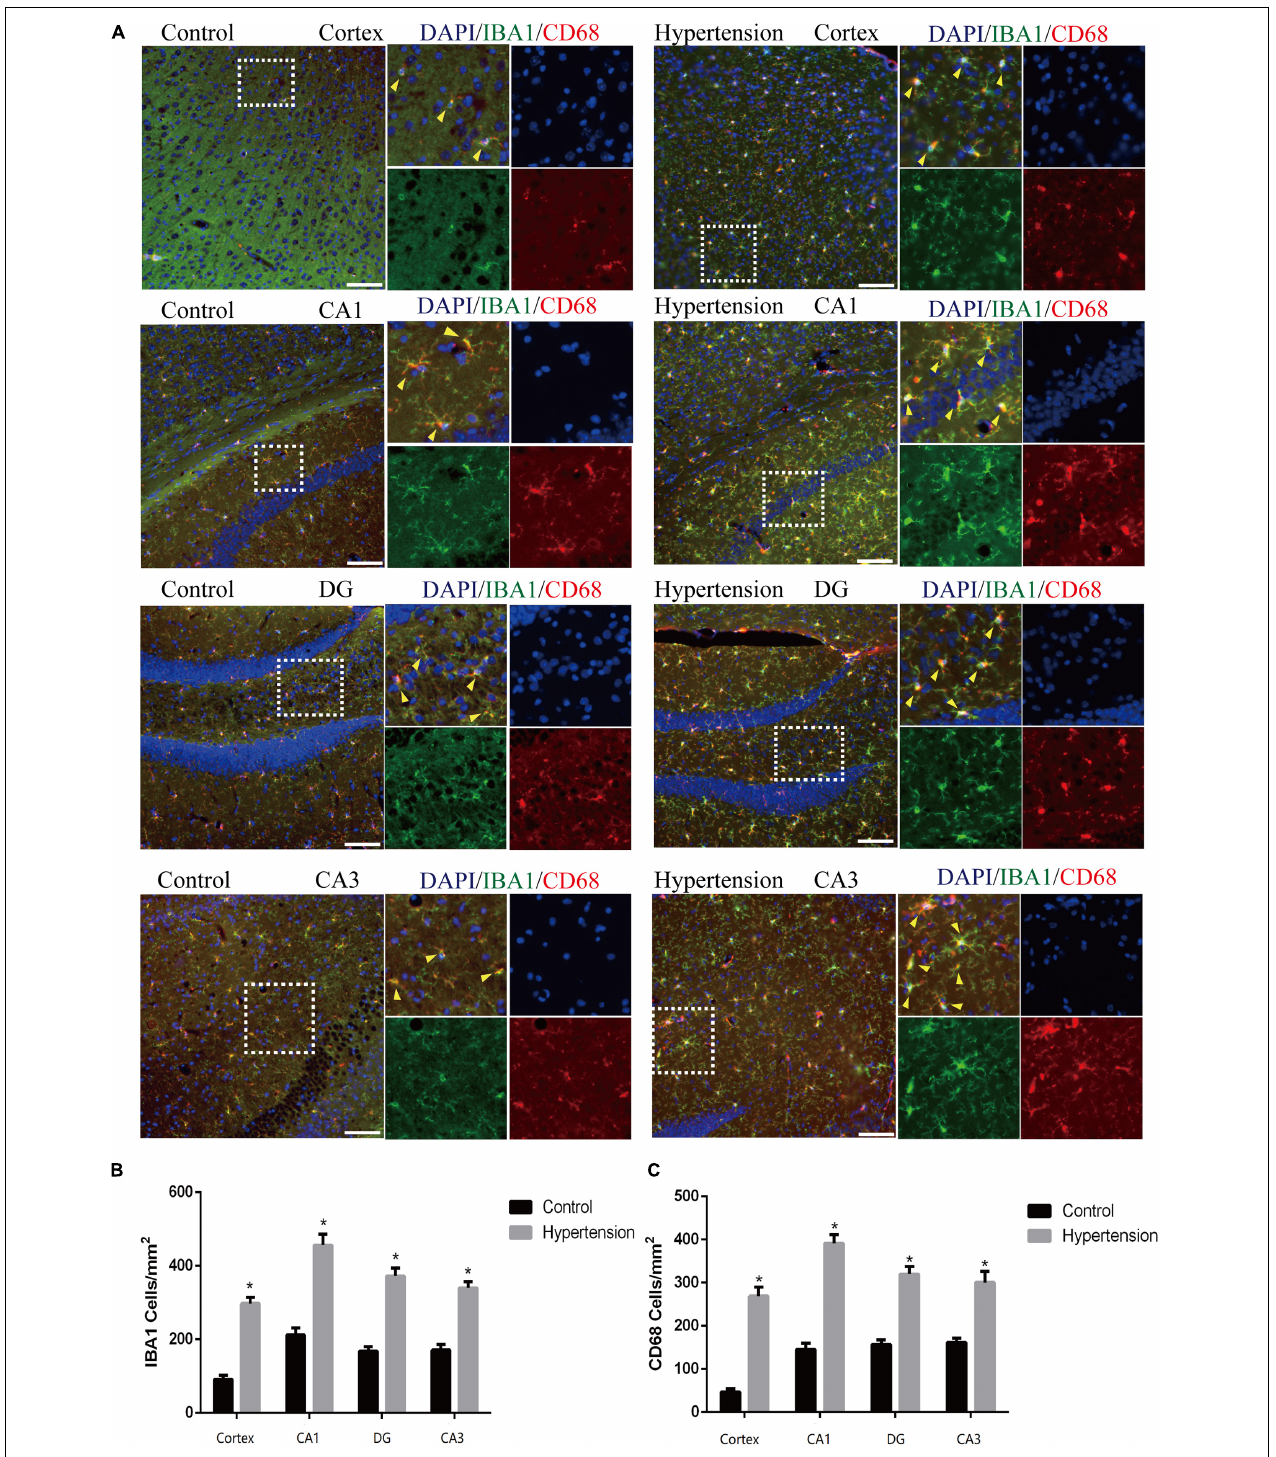
FIGURE 4 | Angiotensin II-induced hypertension upregulates the expression of microglial marker and promotes the activation of M1 microglial transformation in middle-aged mice. (A) Representative images of brain slices stained with the anti-IBA1 (green) and anti-CD68 antibodies (red) in the cortex and hippocampus (CA1, DG, and CA3) of mice in the control and hypertension groups (immunofluorescence, × 20, scale bar = 50 µ m). (B) Histograms comparing the number of IBA1-positive cells in the cortex and hippocampus (CA1, DG, and CA3) of mice in the control and hypertension groups. (C) Histograms comparing the number of CD68-positive cells in the cortex and hippocampus (CA1, DG, and CA3) of mice in the control and hypertension groups. Data are expressed as the means ± SD. * p < 0.05.